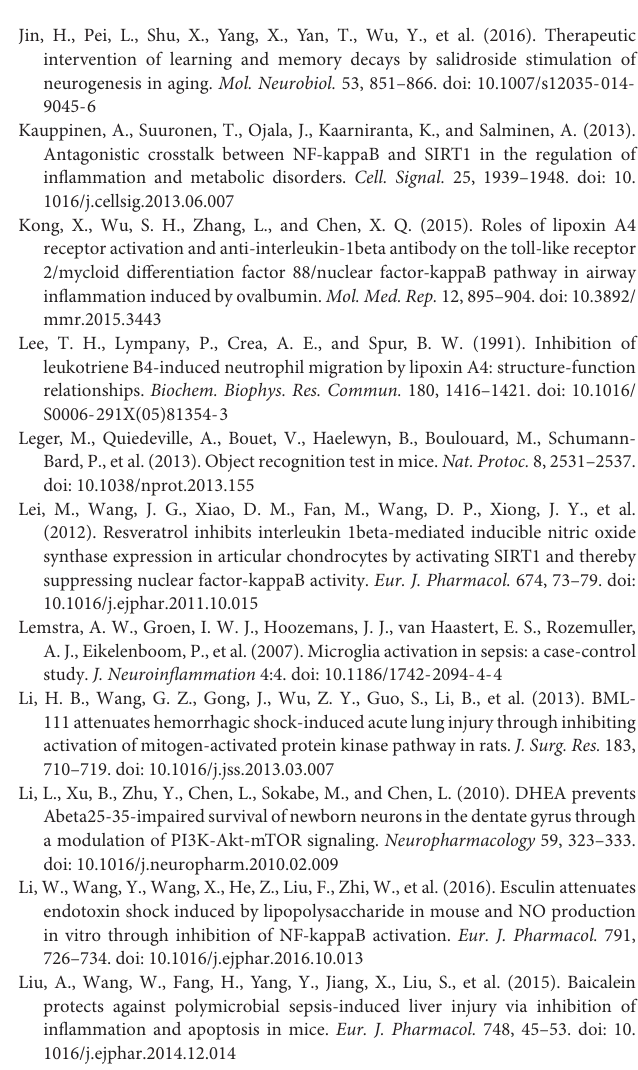
FIGURE S1 | BML-111 administered via intracerebroventricular injection does not affect the peripheral inflammatory response. Sepsis increased the level of TNF- α in the blood, and this was not affected by BML-111 injection. Data were shown as the means ± SEM ( n = 6 survived mice per